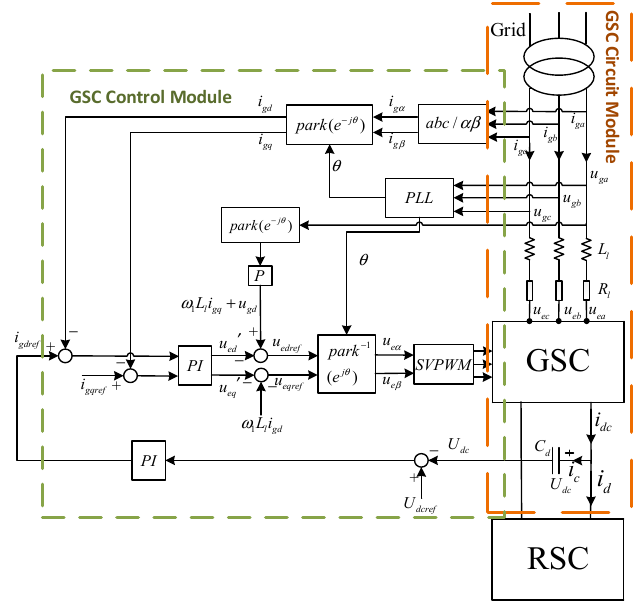
Figure 9. The structure diagram of GSC in DFIG. The orange dash line box is the circuit module of GSC, and the green dash line box is the control module of GSC. The dc link is taken into consideration when modeling the GSC circuit.